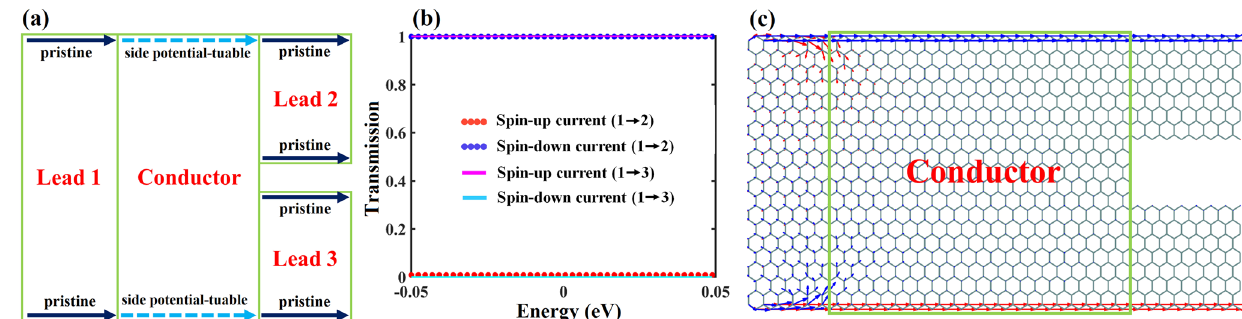
Fig. 8 Transmission spectra and local current distributions of the spin/charge current switcher. a Schematic of the three-terminal spin/charge current switcher. All leads are set as pristine antichiral edge states, and the Conductor is applied on side potential-tunable edge states. b Transmission spectrum of Type-3. c Corresponding local bond current distribution ( E =